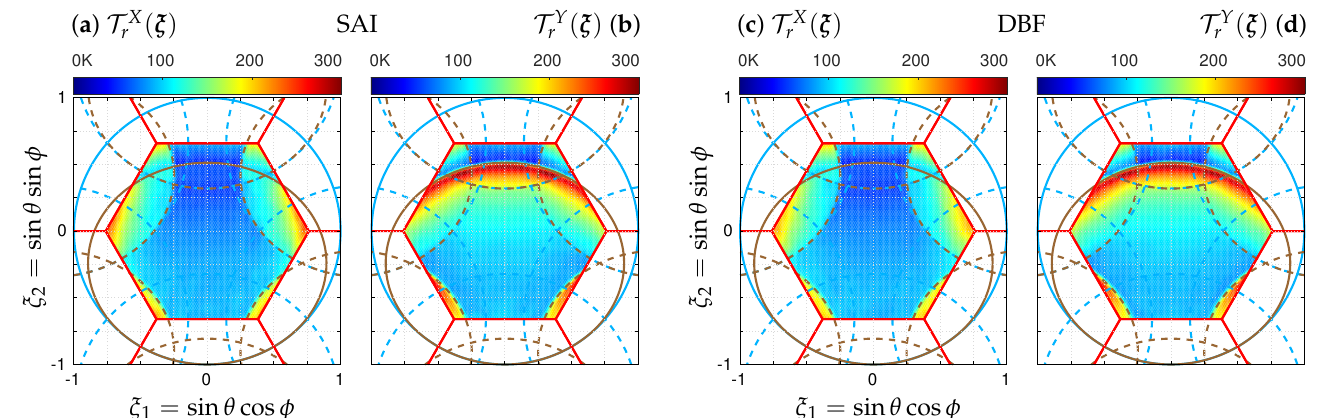
Figure 6. Retrieved brightness temperature maps T r at instrument level in X and Y polarizations corresponding to ( a , b ) the inversion of complex visibilities with the SAI paradigm and to ( c , d ) the inversion of antenna temperatures with the DBF one. Color scale is the same for the four maps.